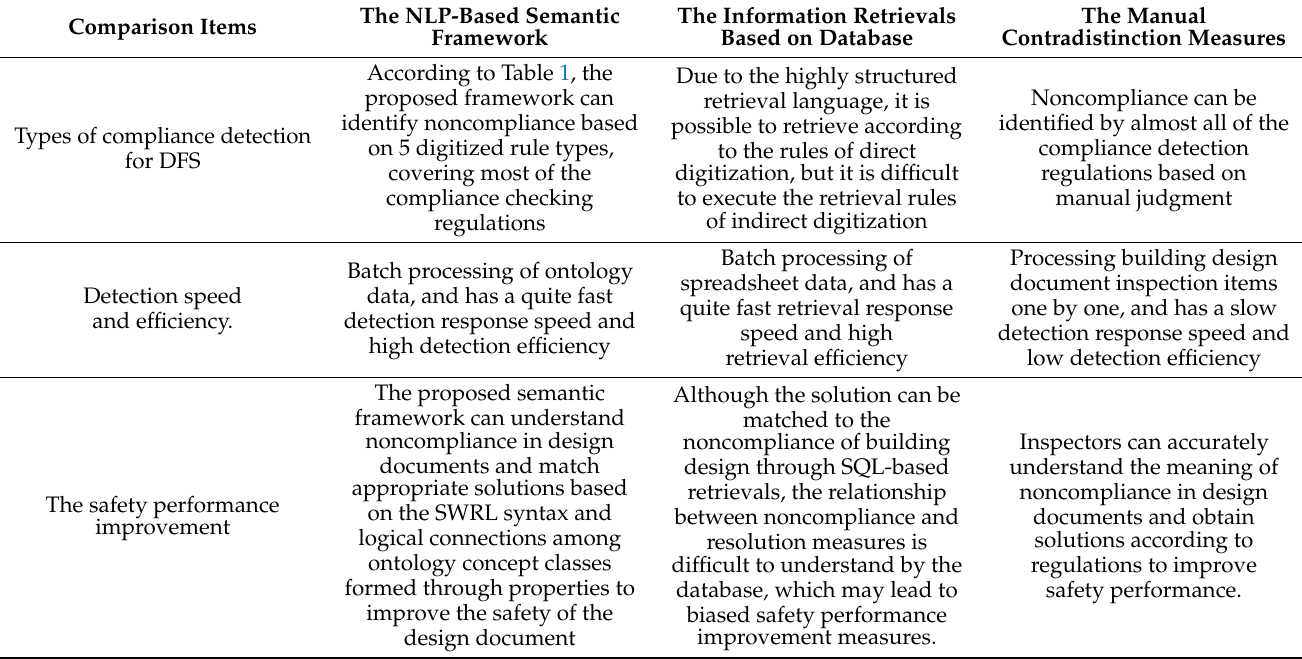
Table 6. A comparison of compliance checking methods in different